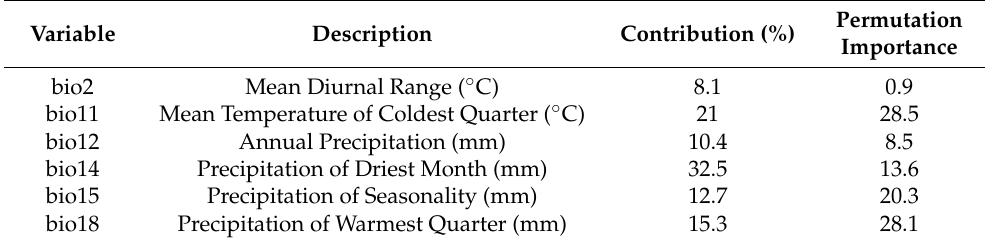
Table 2. Contribution percentage of each environmental variable in the MaxEnt modeling.